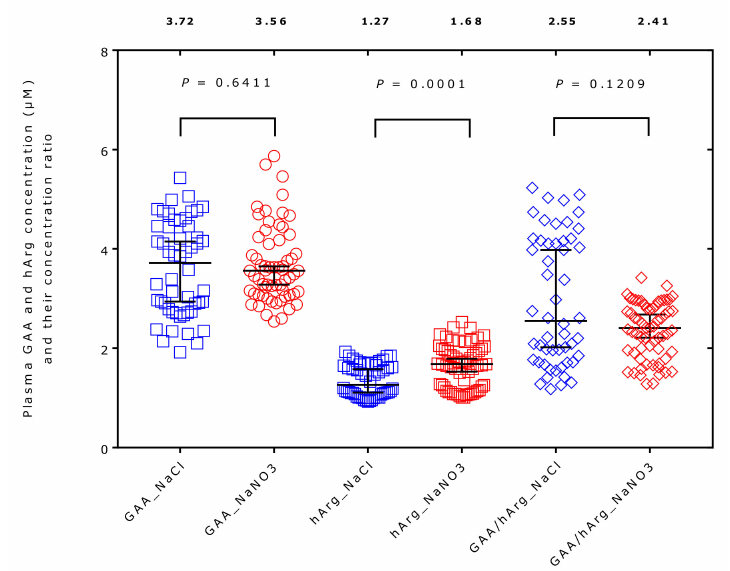
Figure 1. Plasma concentrations of guanidinoacetate (GAA) and homoarginine (hArg) and their molar ratio (GAA/hArg) in the NaCl and NaNO 3 groups after supplementation of NaCl ( n = 52, 54) or NaNO 3 ( n = 63). The plasma concentrations measured at all exercise timepoints were considered. Data are presented as the median with 95% confidence interval. Numbers on the top are median values. Mann–Whitney test was performed between the groups for GAA, hArg, and GAA/hArg.